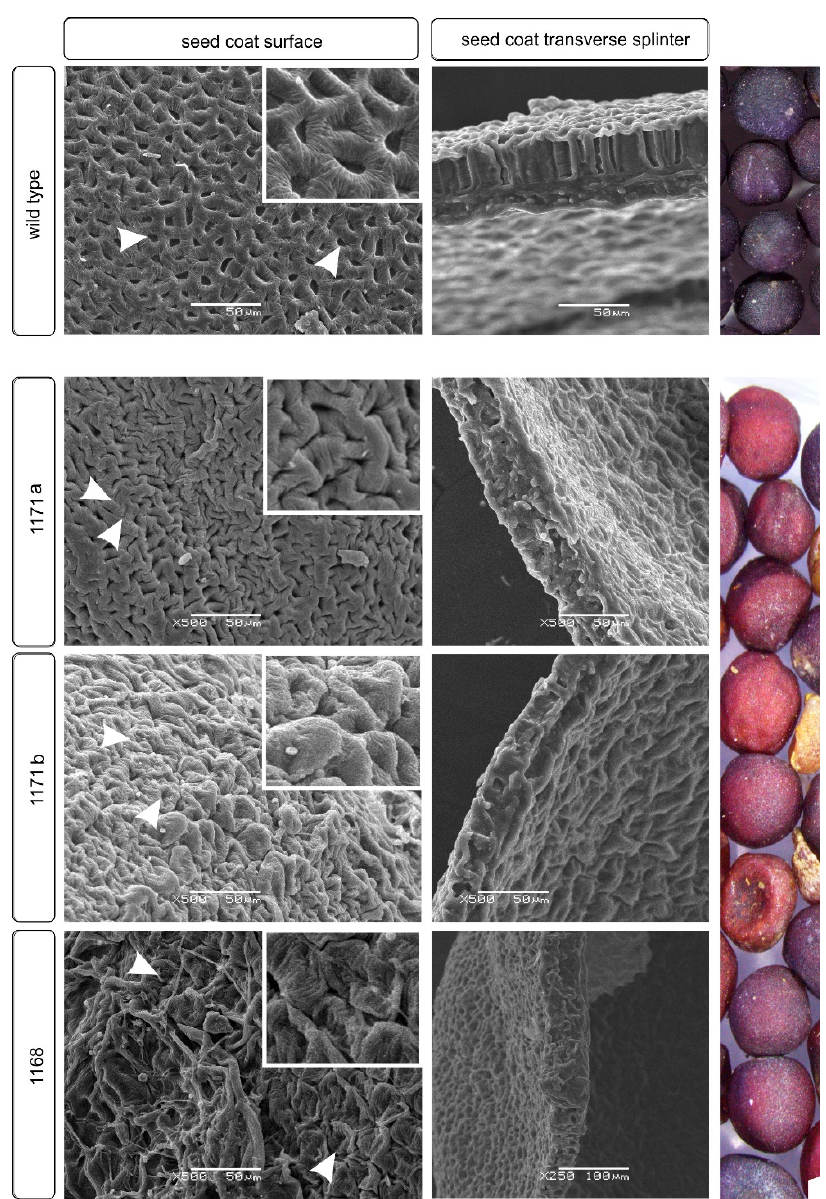
Figure 4. The surface and thickness of the seed coat of wild-type plants, glaucous (1171a), and glossy plants (1171b, 1168). Bar 50 µm; line 1168 chip 100 µm.